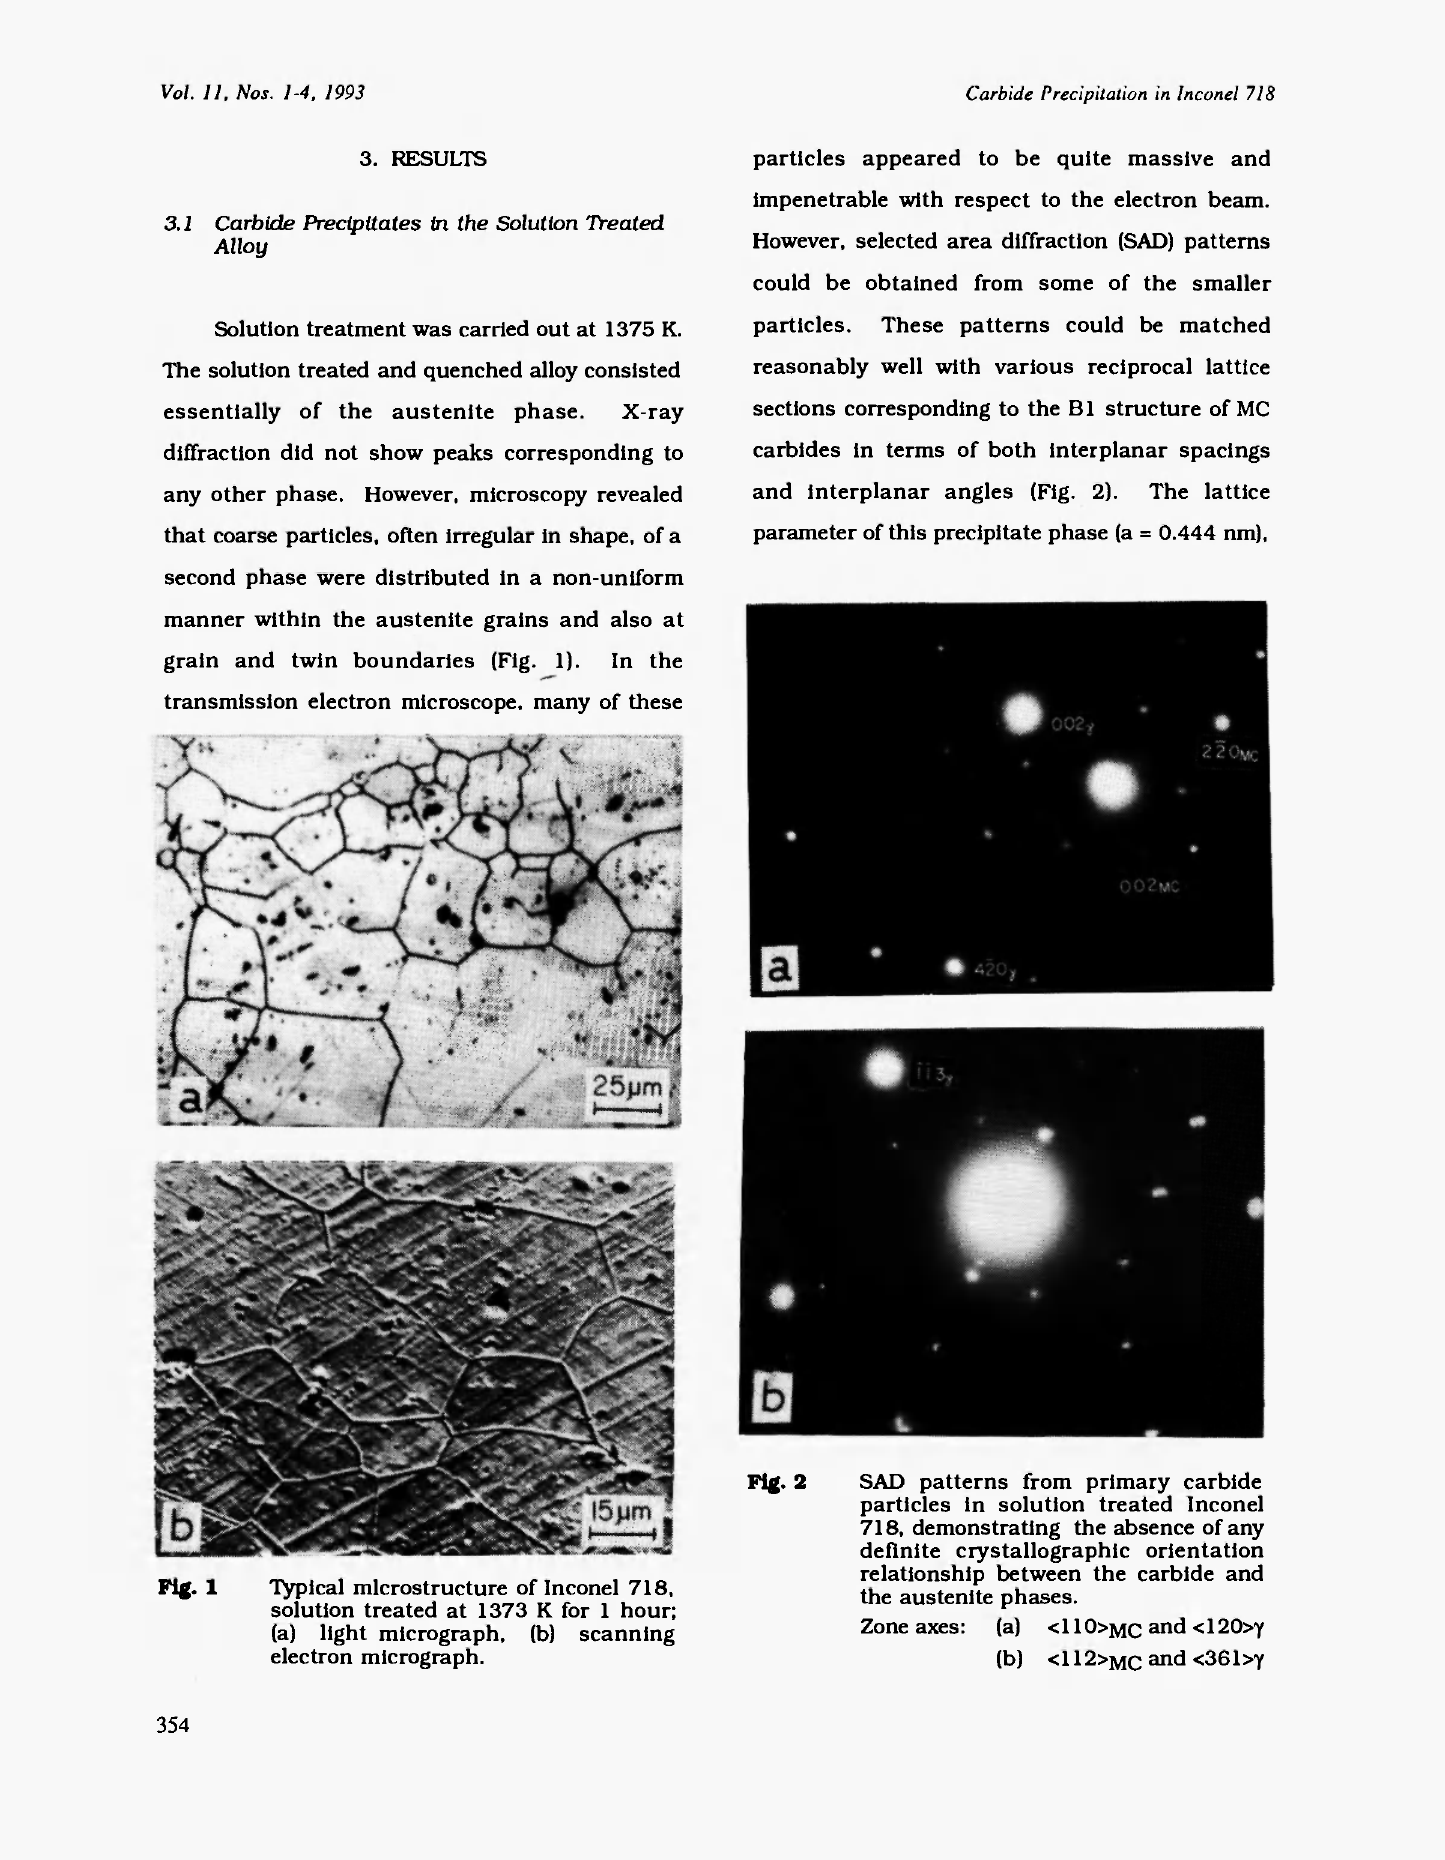
Fig. 1 Typical mlcrostructure of Inconel 718, solution treated at 1373 Κ for 1 hour; (a) light micrograph, (b) scanning electron